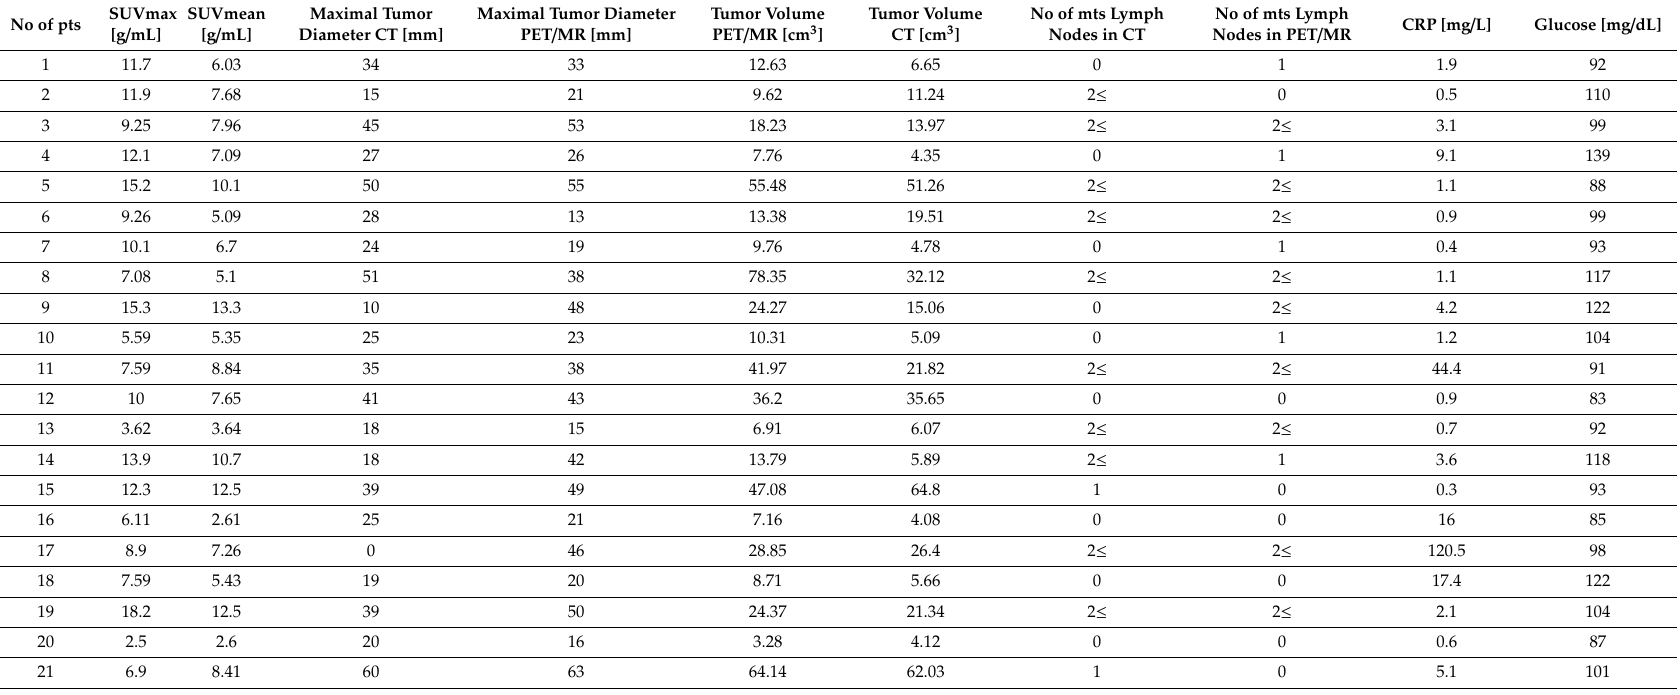
Table 2. Measurements of standardized uptake value (SUV) values, tumor geometrical parameters and number of metastatic lymph nodes obtained from positron emission tomography / magnetic resonance (PET / MR) and computed tomography (CT), as well as biochemical parameters in pts (patients) with head and neck squamous cell